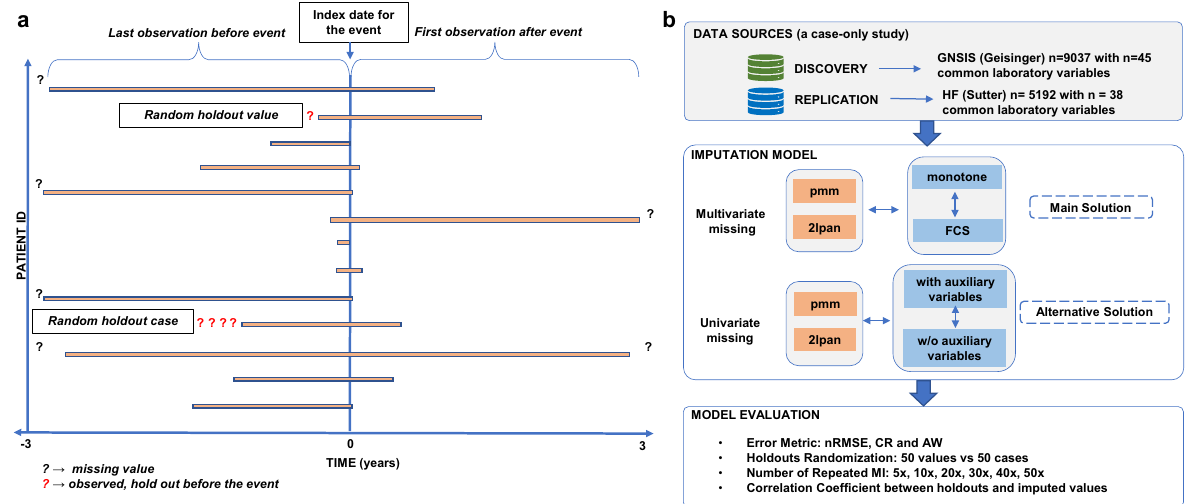
Fig. 1 Data extraction and analysis pipeline. 1a Inspired by a stepwise imputation by observation blocks in longitudinal data from EHR, we extracted the last observation before an event (e.g., stroke or heart failure), and the fi rst observation after the event. Two types of holdouts, random holdout values (HV) and random holdout complete cases (HC), represent two missingness scenarios, MAR and monotone with NMAR, respectively. 1b Outline the tested imputation models and algorithms evaluated by error metrics and the results after repeated multiple imputation (MI). Abbreviations: PMM predictive mean matching, 2lpan Implements the Gibbs sampler for the linear two-level model with homogeneous within-group (patient ID) variances, LMM linear mixed-effects model, FCS fully conditional speci fi cation, nRMSE Root Mean Square Error normalized by standard deviation, CR Coverage rate, the proportion of con fi dence intervals that contain the true